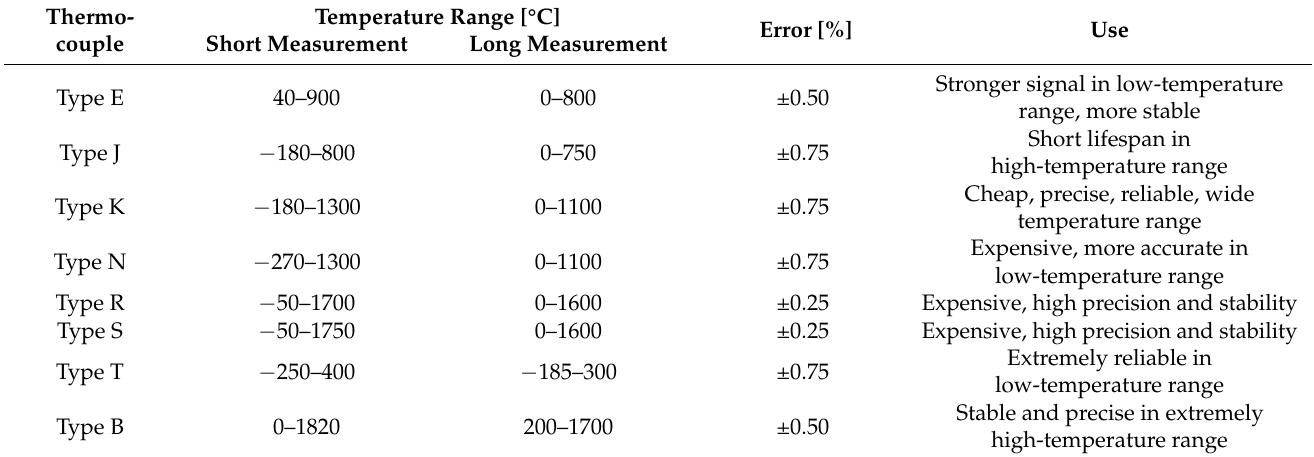
Table 6. Review of thermocouples with main